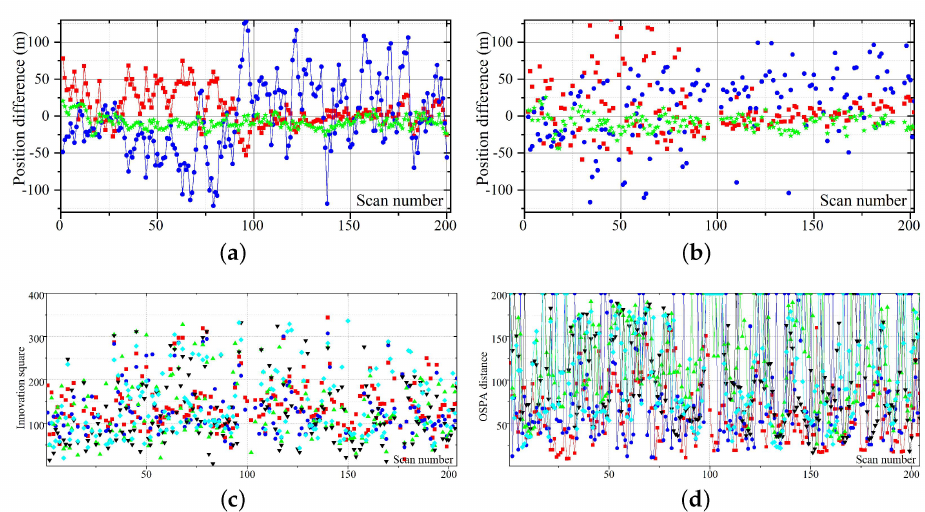
Figure 8. ( a ) The position difference between the smoothed track and ground truth of X, Y, and Z axes using the proposed method. ( b ) The position difference between the smoothed track and ground truth of X, Y, and Z axes using the ET-PHD filter [35]. ( c ) The innovation square of the proposed method and four comparisons [35–38]. ( d ) The OSPA distance of the proposed method and four comparisons [35–38]. In ( c , d ), red squares mean the proposed method, blue balls mean the ET-PHD [35], green triangles mean the CPHD filter [36], black inverted triangles mean the Bernoulli filter [37], and cyan diamonds mean the GLMB filter [38].